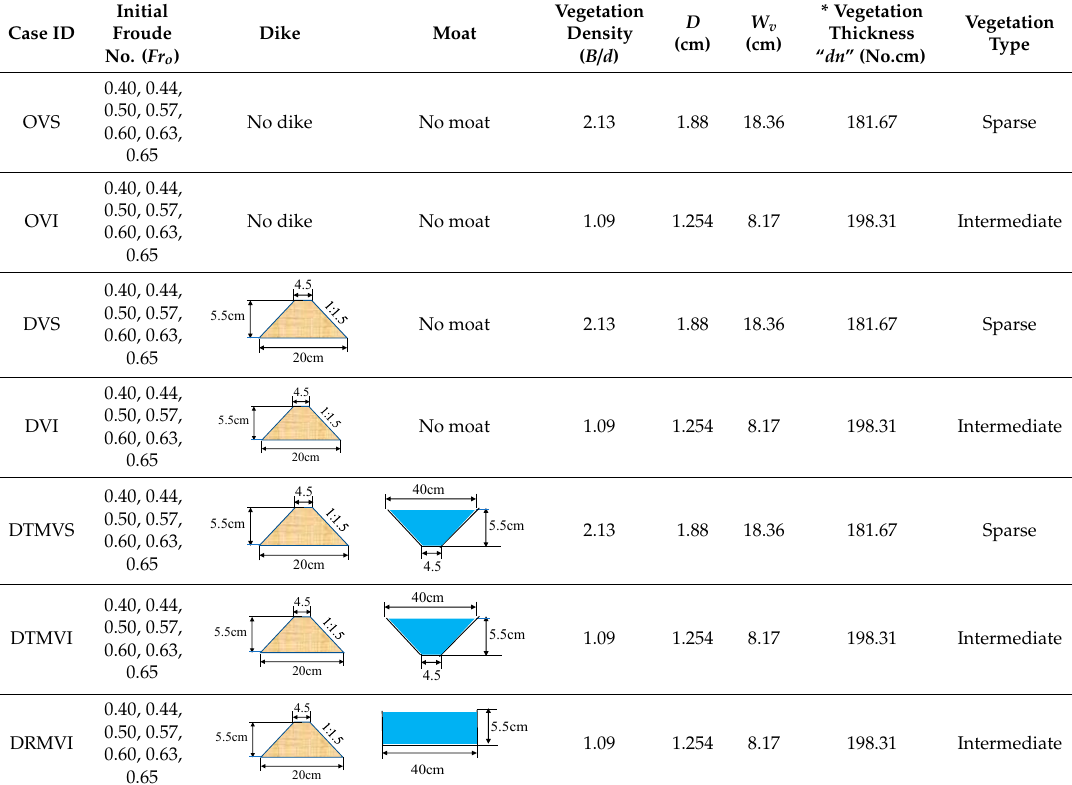
Table 1. Experimental conditions of a hybrid defense system.